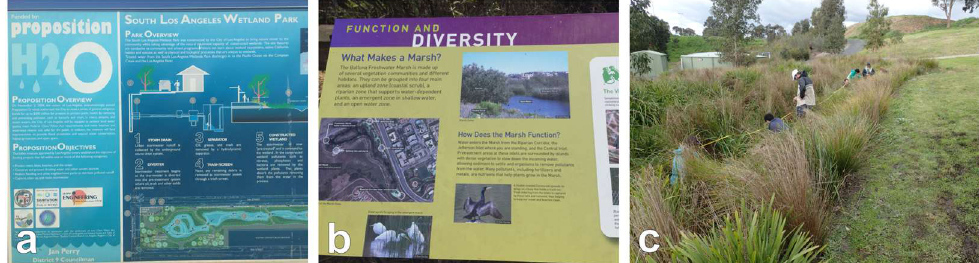
Figure 8. Examples of education and outreach services provided by natural stormwater treatment systems: ( a ) South Los Angeles Wetlands Park, ( b ) Ballona Freshwater Marsh, and ( c ) students con- ducting fieldwork as part of the National Science Foundation Partnerships for International Re- search and Education.